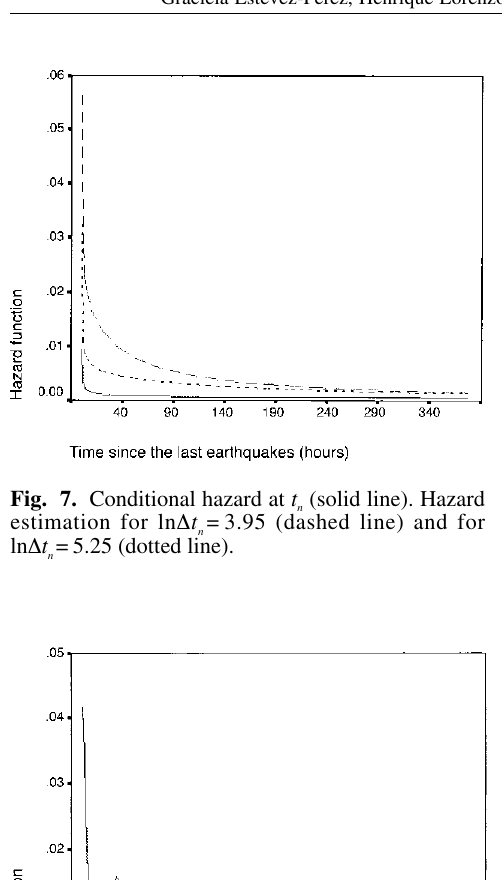
Fig. 8. Hazard estimation under